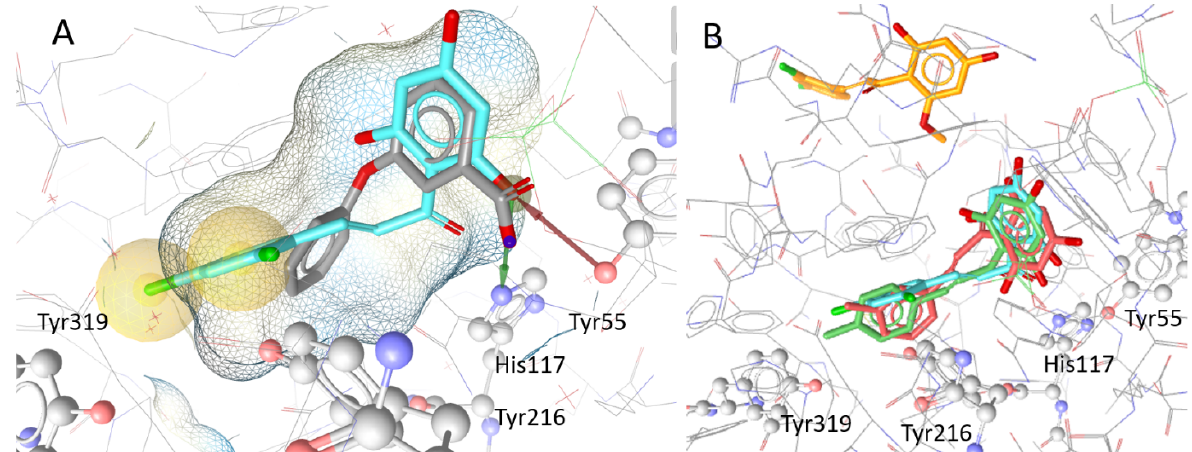
Figure 6. Localisation and orientation of chalcones to AKR1C3 in docking simulations: ( A ) docking pose of the protein (PDB Code: 3UWE) with its co-crystallised ligand 3-phenoxybenzoic acid (gray; IC 50 = 0.68 µM) and compound 23 (cyan), the compound with the highest inhibitory effect. The hydrophobic interactions between compound 23 and Tyr319 and Tyr216 are highlighted in yellow. The red and green arrows indicate hydrogen bonds between the hydroxy group of ring B of 23 and Tyr55 and His117, respectively; ( B ) shows the docking poses of the highly inhibiting chalcones 23 (cyan), 20 (red), and 21 (green) in comparison with weak inhibitor 25 (orange), which was placed outside the binding pocket in